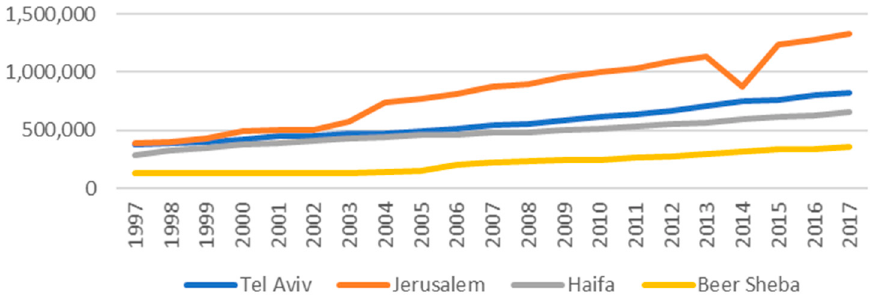
Figure 2. Revenues—residential property tax (NIS, thousands).